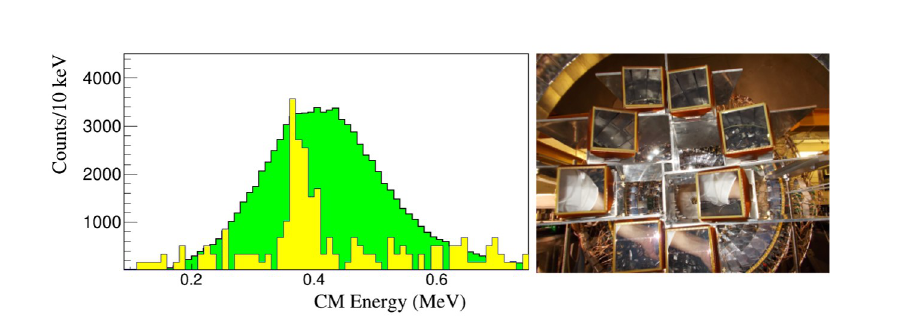
Figure 2. Left - The green spectrum is the Hoyle CM energy spectrum reconstructed with CHIMERA data, the yellow spectrum is the one reconstructed by using FARCOS telescopes in a preliminary test experiment, (random coincidences are not subtracted). Right - photo of one of the adopted configuration for the FARCOS array inside